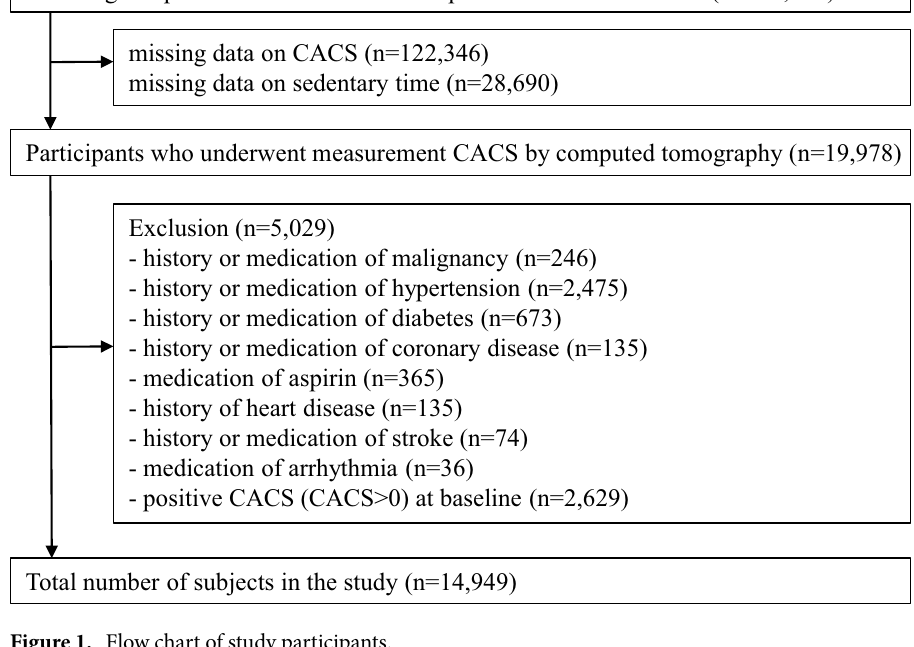
Figure 1. Flow chart of study